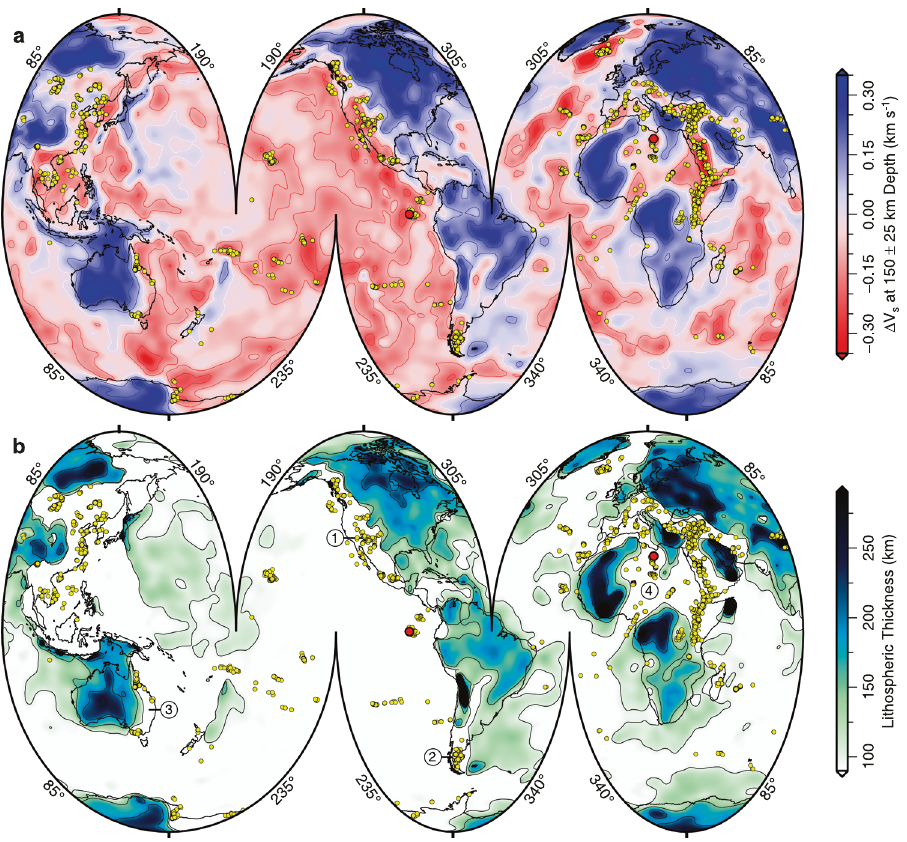
Fig. 1 Neogene-Quaternary intraplate volcanism. a Segmented Mollweide projection of globe showing average value of shear-wave velocity anomaly, Δ V s , taken from SL2013sv tomographic model at depth of 150 ±25km 21 . Red/white/blue contours = positive/zero/negative values of Δ V s plotted at intervals of 0.1 kms − 1 ; yellow circles = loci of intraplate magmatic samples <10Ma and located<400km from locus of eruption based upon present-day plate speeds (see Supplementary Materials for Database 1). Two red circles = loci of Galápagos and Haruj provinces used for geochemical modeling in Fig. 4. b Spatial variation of lithospheric thickness calculated using intersection of 1175°C isothermal surface from SL2013sv tomographic model that is converted into temperature 27 . Black contours = thickness values at intervals of 50km. Encircled numbers highlight loci where gently dipping Late Cretaceous-Cenozoic marine strata crop out at elevation: 1 = western North America; 2 = southernmost South America; 3 = eastern Australia; and 4 = north Africa 55